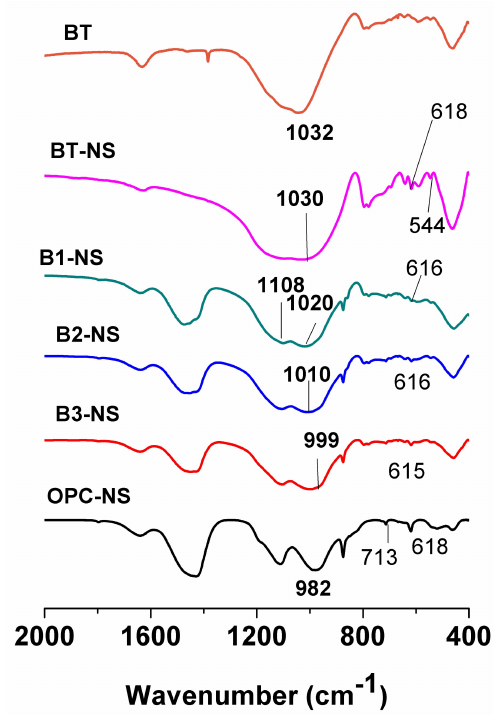
Figure 5. FTIR Spectra for hydrated systems BT, OPC, B1, B2 and B2 (2 days) from 2000 cm − 1 to 400 cm − 1 with activator